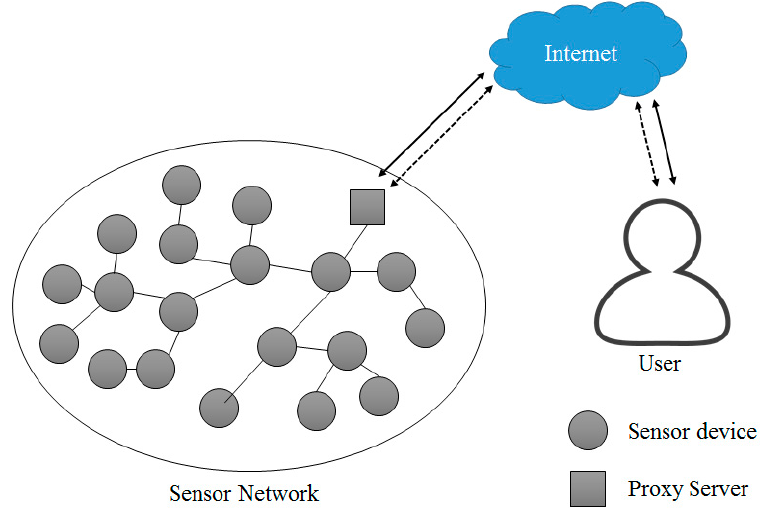
Figure 4. Sensor Network Configuration in the IoT environment.